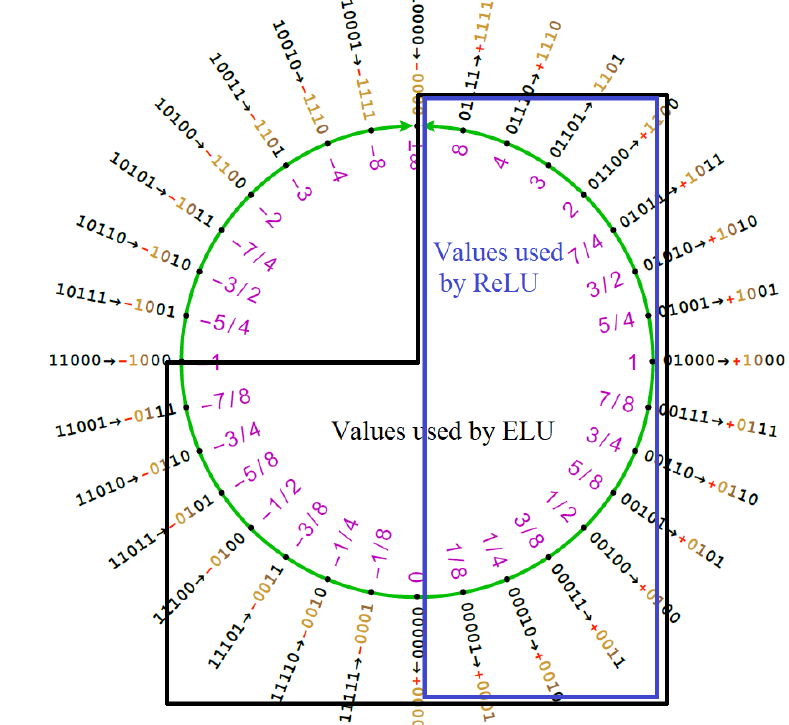
Figure 7. The Posit circle when the total number of bits is 5: The extended linear unit uses all the numbers in [ − 1,inf ) , while the ReLU function uses only the ones in [ 0,inf )